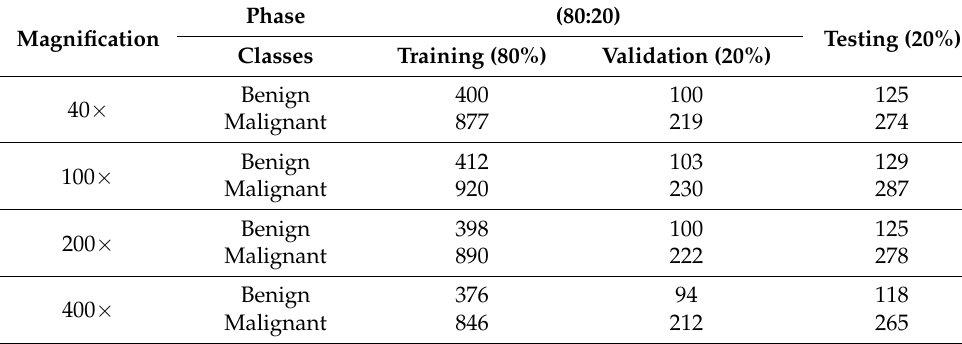
Table 2. Splitting of the HI of BC during all phases.